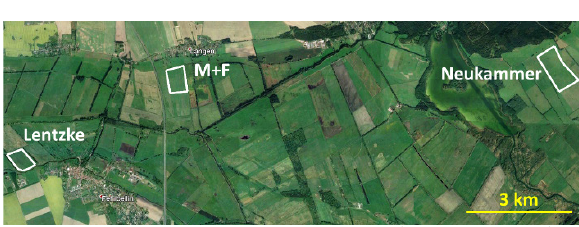
Figure 3. Test grasslands Lentzke (0.2 km 2 ), M+F (0.3 km 2 ), and Neukammer (1.0 km 2 ) in State of Brandenburg, Germany.